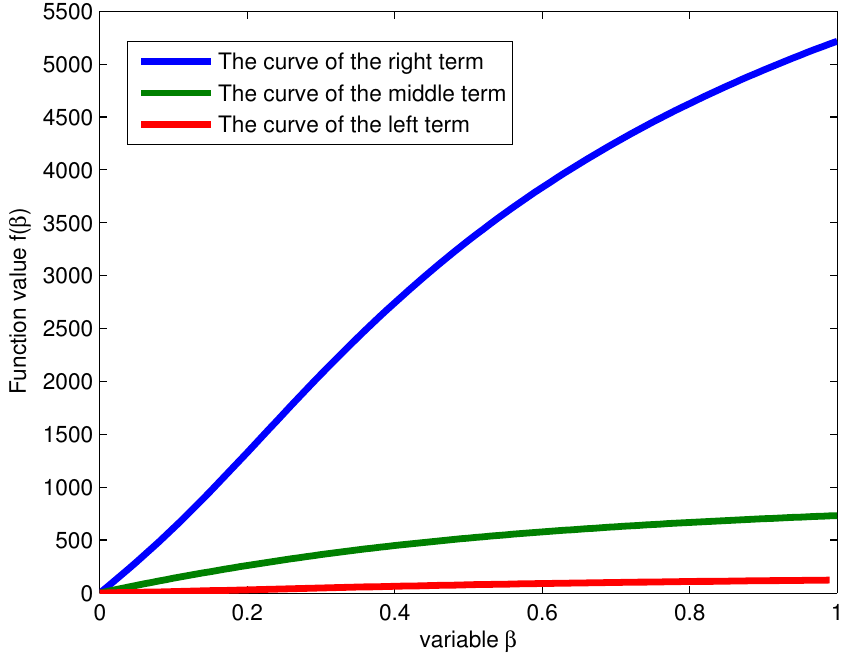
Figure 4. The image description of Theorem 2 for h ( t ) = e t and g ( ξ ) = e 2 ξ